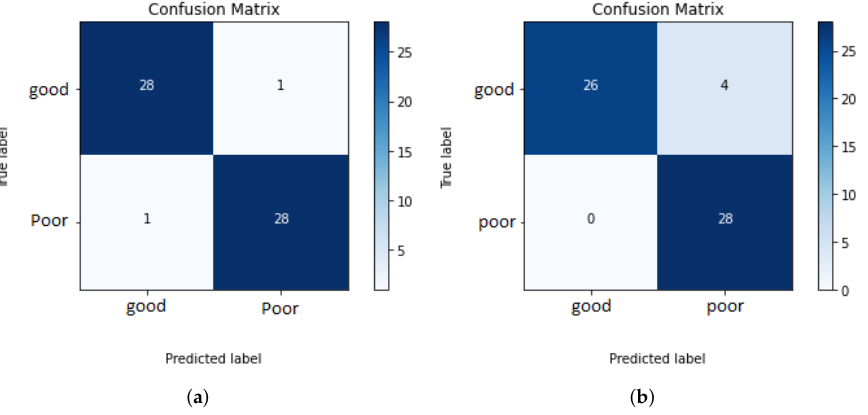
Figure 35. Confusion matrices of overall systems 1 and 2. ( a ) Assessment of the breast positioning quality by CC views. ( b ) Assessment of the breast positioning quality by MLO